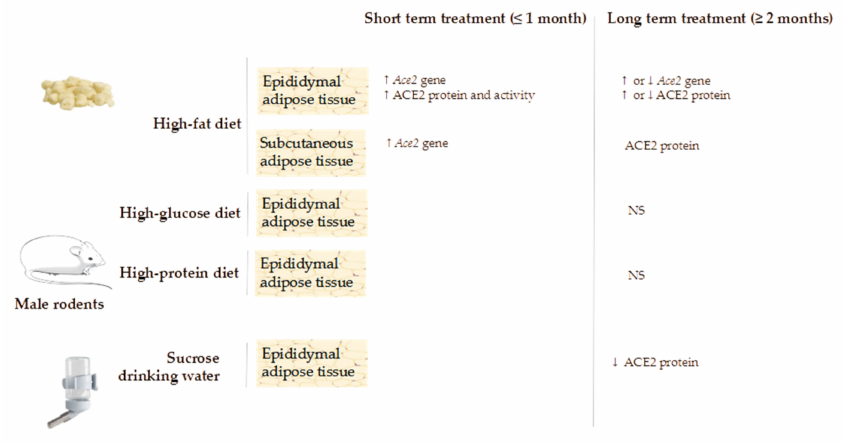
Figure 4. Effects of diet composition on ACE2 gene and protein expression in adipose tissue. NS: non-significant; ↑ : increase; ↓ :